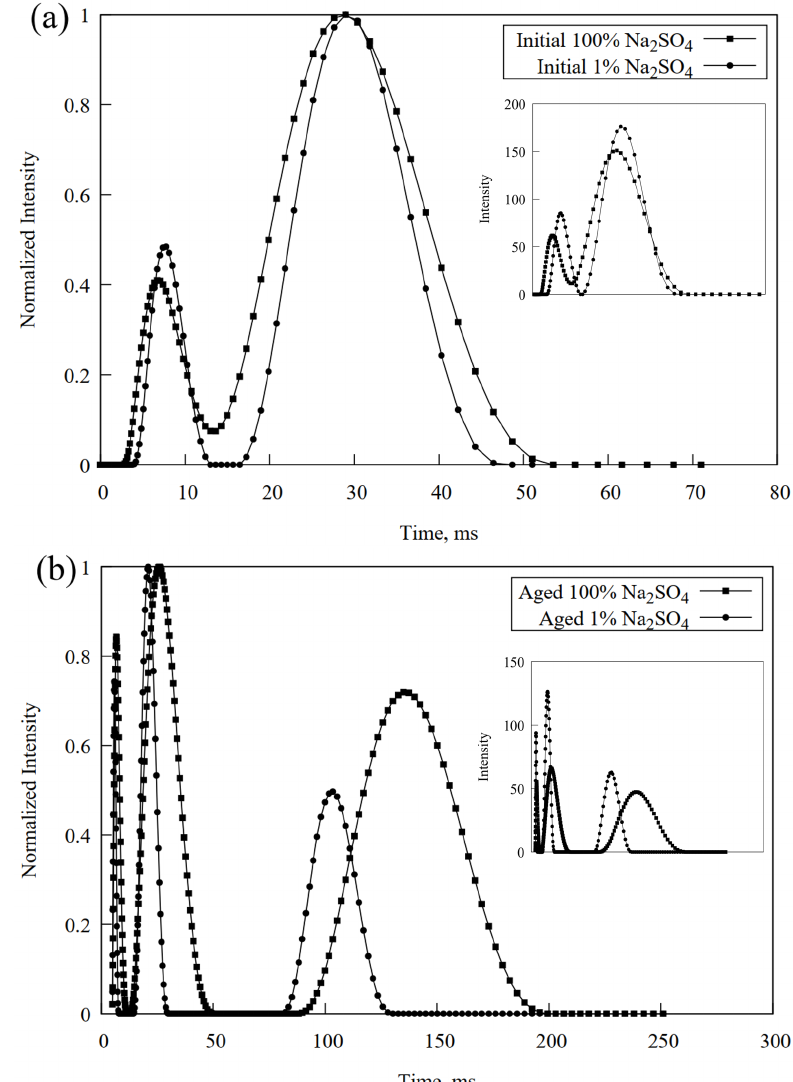
Figure 13. Relaxation time distribution (T 2 ) of Berea Sandstone: ( a ) Initial “oil-wet” state (aged in crude oil for 21 days at 80 ◦ C); ( b ) Effects of aging in 1% Na 2 SO 4 and 100% Na 2 SO 4 at 25 ◦